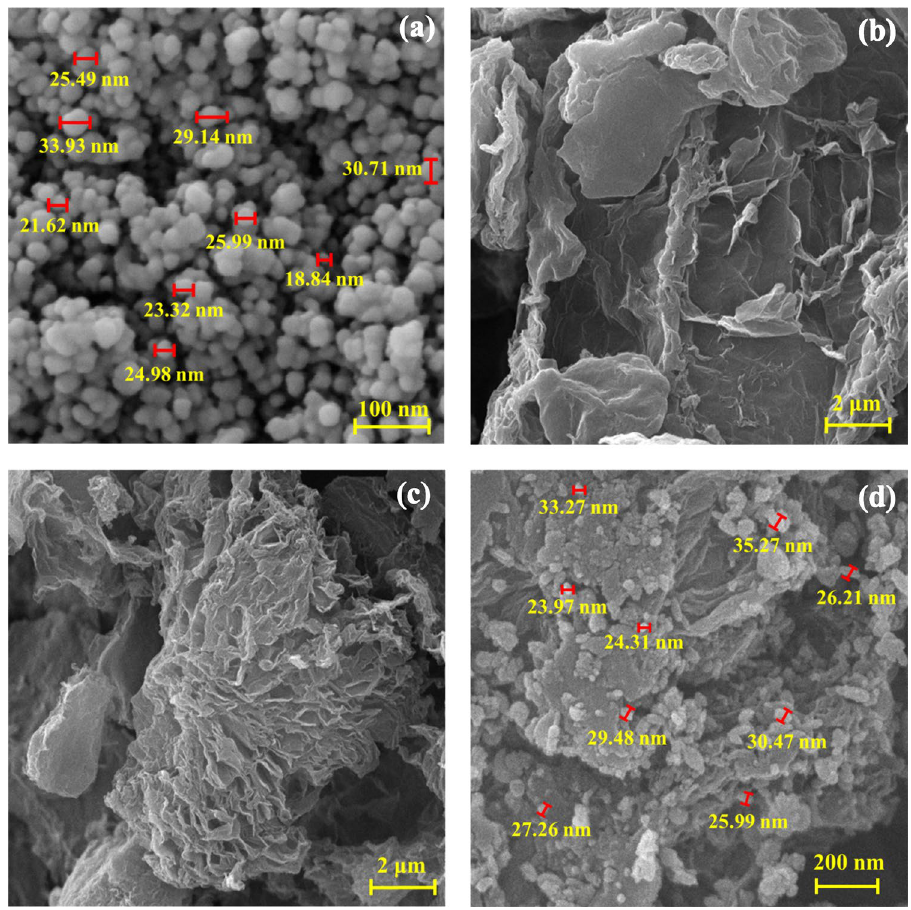
Figure 4. FE-SEM image of ( a ) ZnO, ( b ) Graphene oxide-lignin, ( c ) Graphene oxide-lignin/silk fibroin, and Graphene oxide-lignin/silk fibroin/ZnO